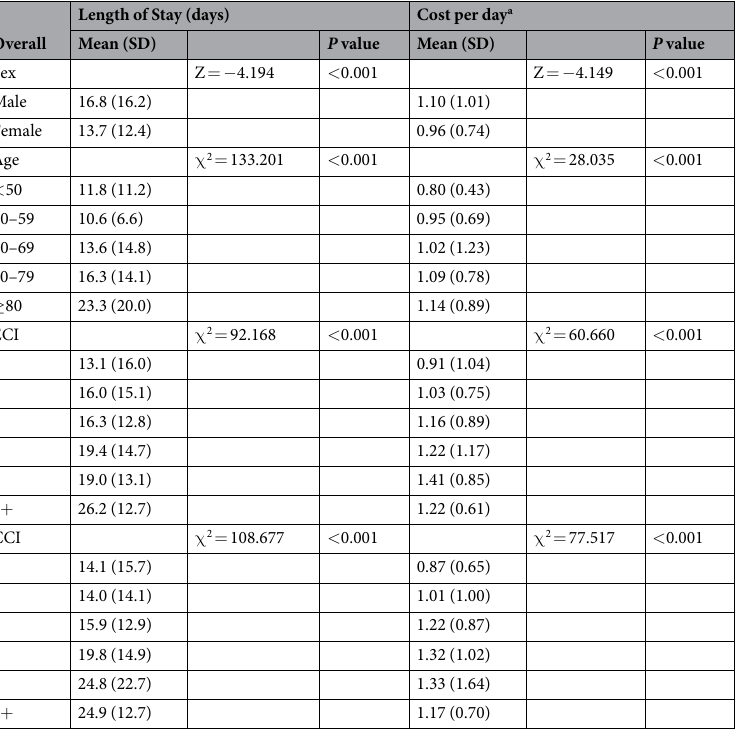
Table 2. Length of stay and hospitalization expense for all patients. a Each value was divided by 1057 for